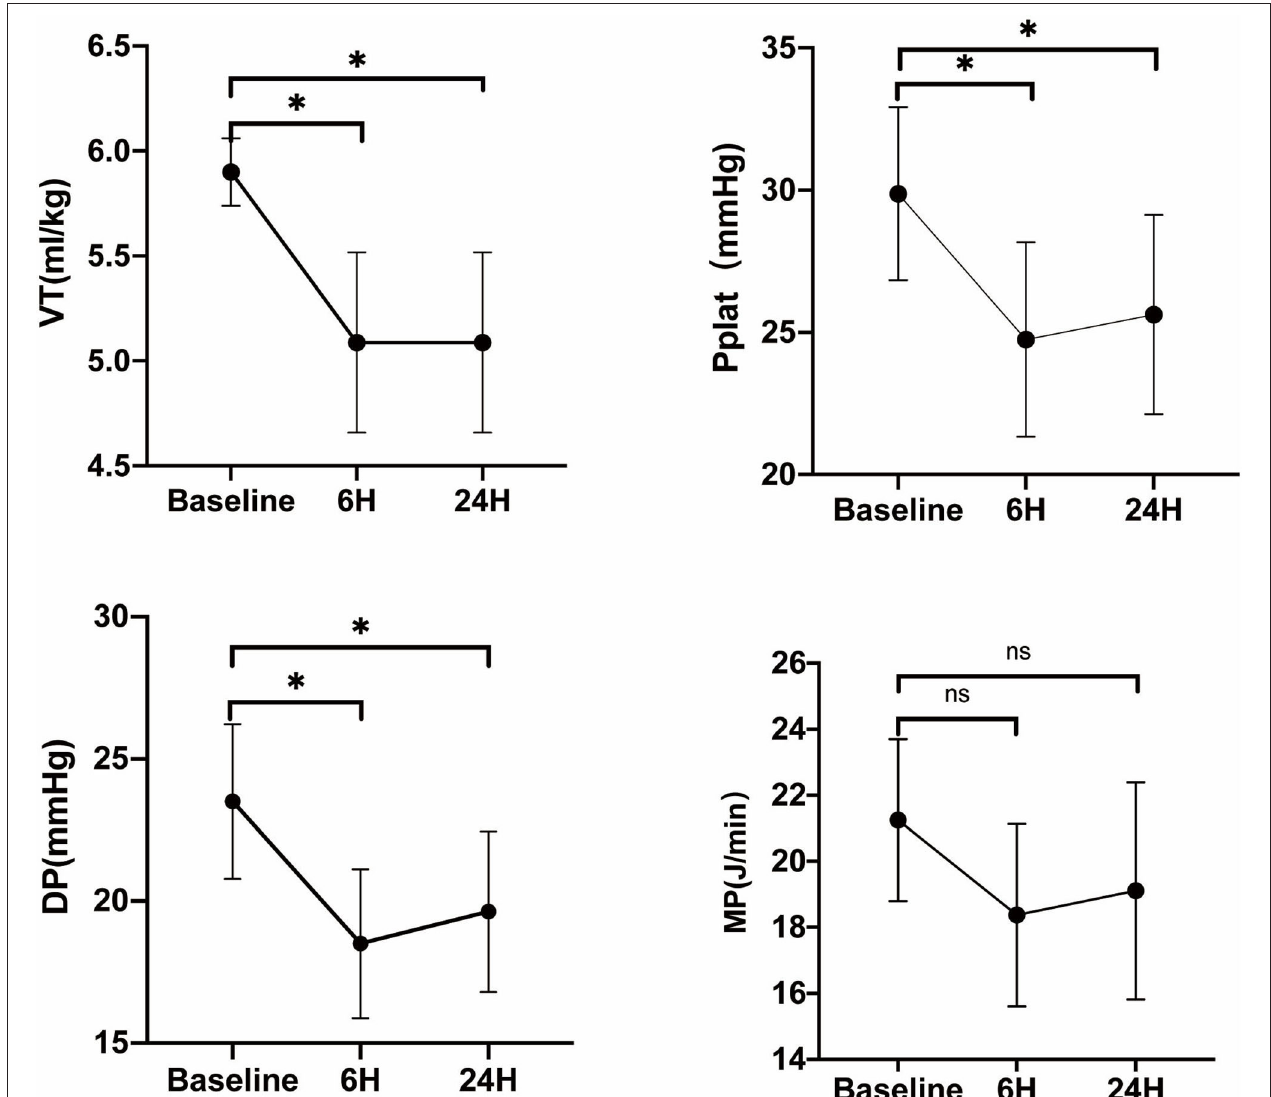
FIGURE 4 | Evaluation of VT, Pplat, DP, and mechanical power when tidal volume was reduced on ECCO 2 R in the adjusted group. Vt, tidal volume; Pplat, end-inspiratory plateau pressure; DP, driving pressure; MP, mechanical power. * p < 0.05 vs.